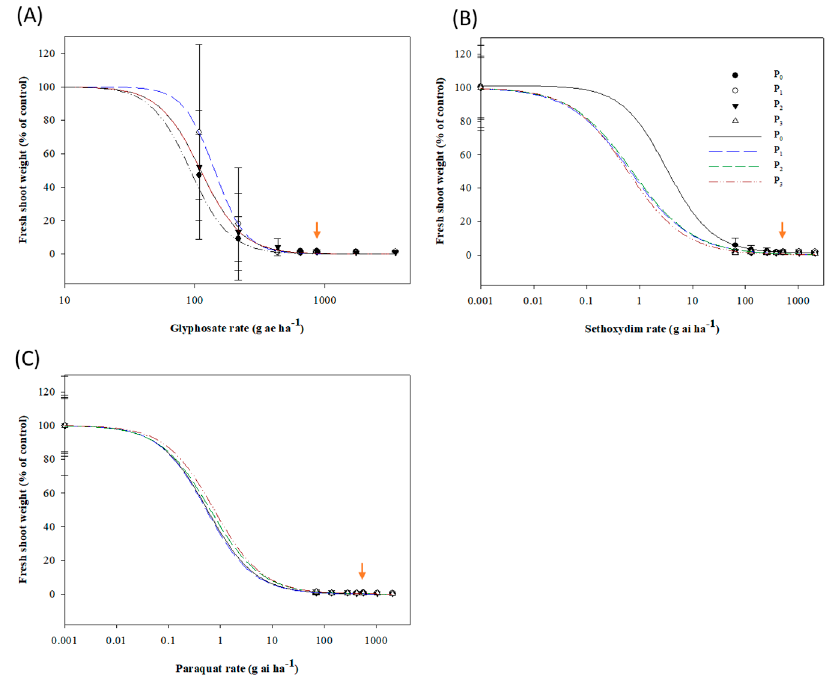
Figure 2. Dose–response of L. perenne ssp. multiflorum parental (P 0 ) and three successive generations (P 1 , P 2 , P 3 ) of progeny, selected with low rates of glufosinate, to treatment with glyphosate ( A ), sethoxydim ( B ), and paraquat ( C ) in the greenhouse. Lines are the predicted values for fresh shoot weight. Red arrows indicate the labelled field rates for glyphosate (867 g · ae · ha − 1 ), paraquat (560 g · ai · ha − 1 ), and sethoxydim (515 g · ai · ha − 1 Table 3. Percentage of plants from the parental population (P 0 ) and three generations of progeny (P 1 – P 3 ) that survived treatment with glyphosate, paraquat, and sethoxydim 21 DAT a . % Survivors at Each Herbicide Rate